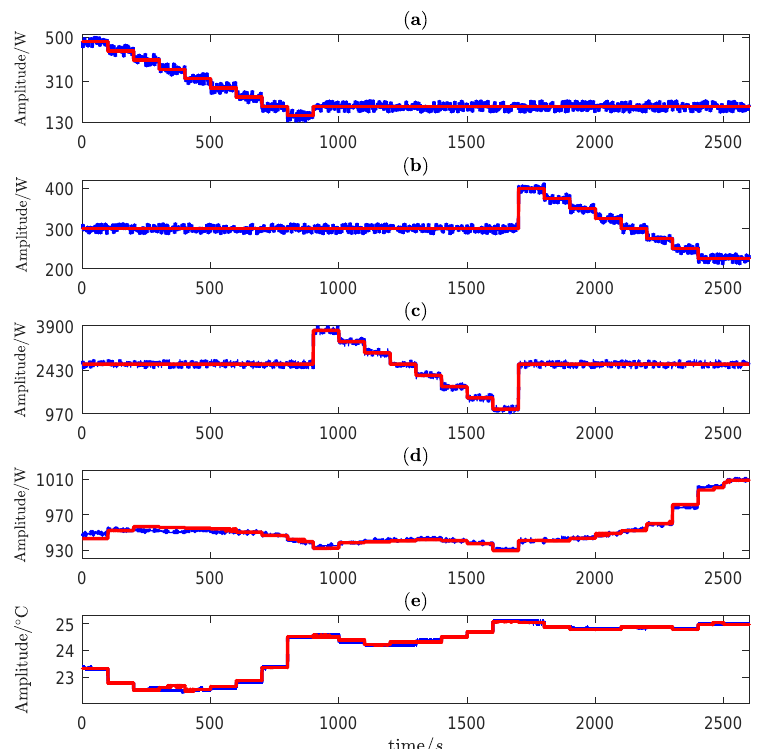
Figure 7. The measureds (blue dot) and estimated (red solid) output variables for coefficient estimation: ( a ) P SA , ( b ) P CW , ( c ) P CHW , ( d ) P chiller and ( e ) T in .